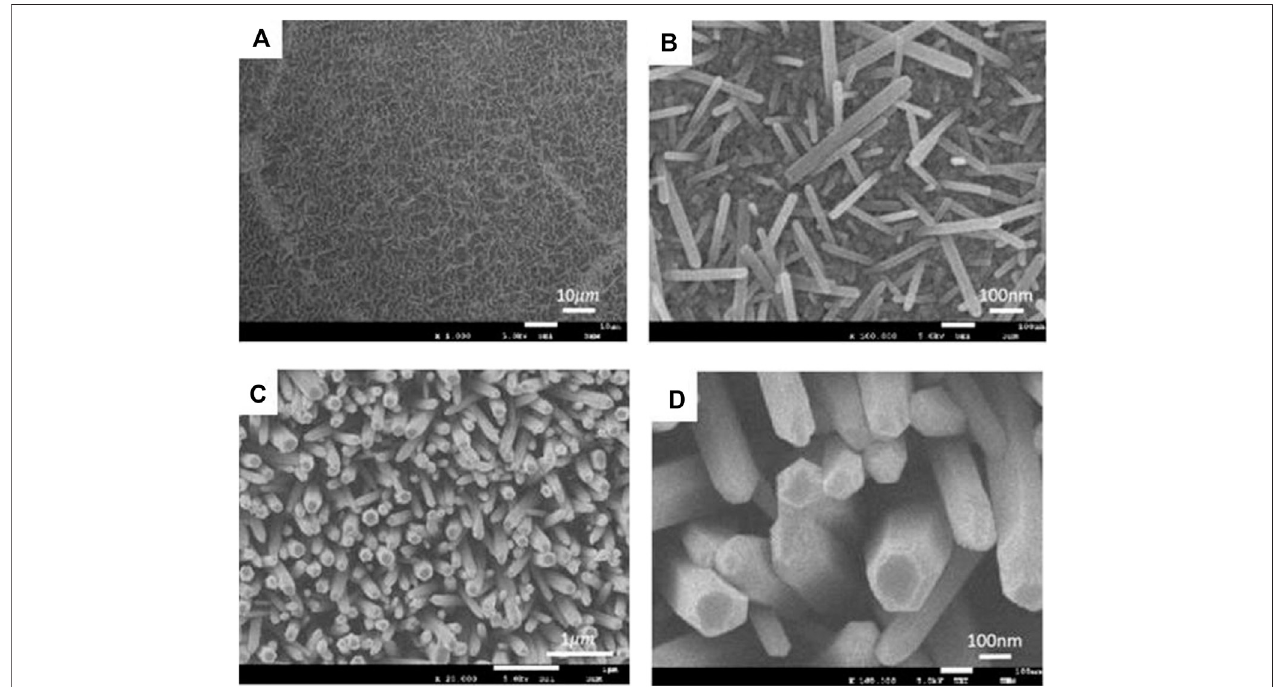
FIGURE4| SEMimagesoftheZnOnanorodsonthegraphenesheetswithzincnitratehexahydrateof10 mM (A) ,15 mM (B) ,and25 mM (C) ,respectively,for5 h.